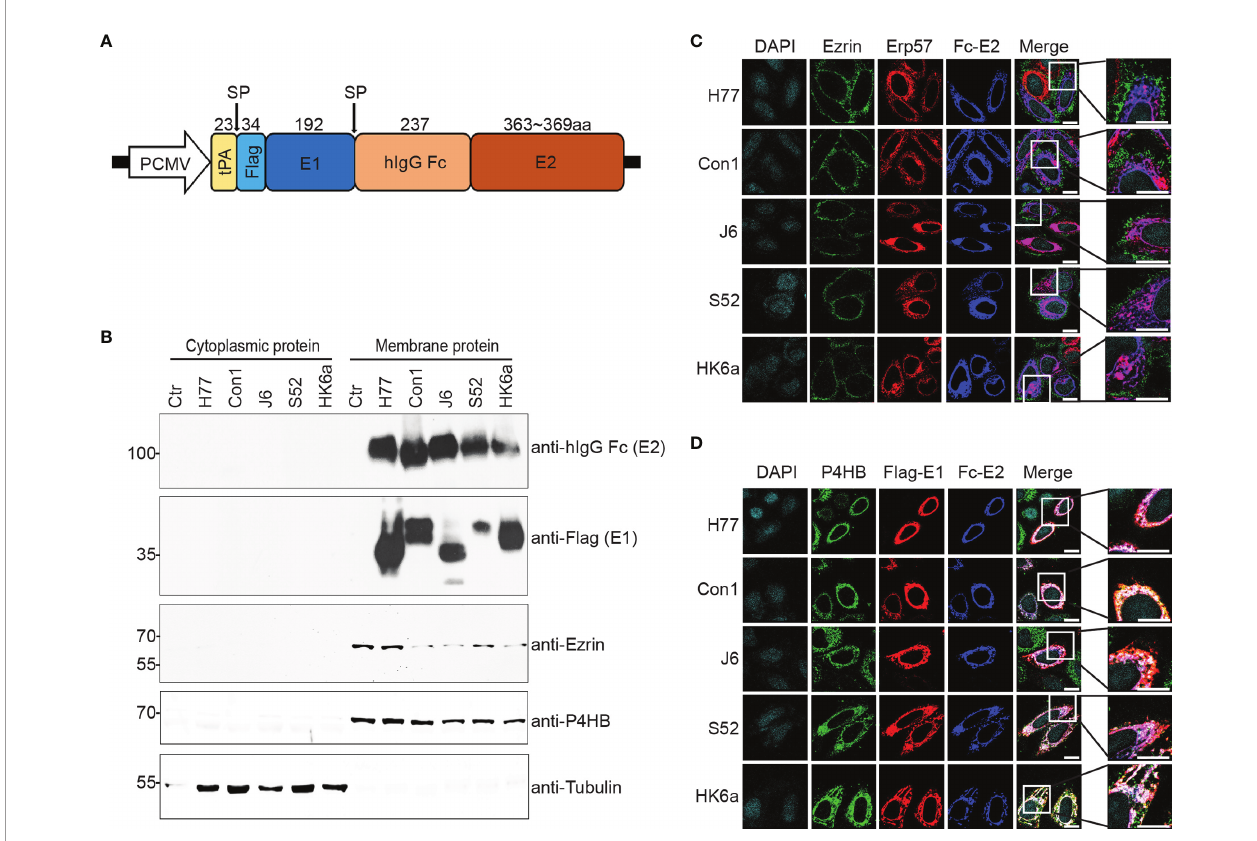
FIGURE 1 | Construction, expression and puri fi cation of Fc-E1E2. (A) Schematic representation of the Fc-E1E2 expression plasmid. The full E1E2 was tagged with the tissue plasminogen activator (tPA) signal sequence and fl ag-tag at the N-terminus of E1, and the human IgG1 Fc fragment (hIgG Fc) was inserted between E1 and E2. The cleavage sites by signal peptidase (SP) and the size of the polypeptide regions (aa, amino acids) are shown at the top. (B) Western blotting (with anti- hIgG Fc, anti-Flag, anti-Ezrin, anti-P4HB, and anti-tubulin antibodies) of cytoplasmic and membrane extracts from FreeStyle 293-F cells. (C, D) The subcellular location of E2 and ER colocalization of E1 and E2 were revealed using confocal laser microscopy. The nuclei were stained with DAPI, and the ER was detected with anti-P4HB and anti-HA (Erp57 expression plasmid was tagged with HA) antibodies. The plasma membrane was detected with anti-Ezrin antibodies. Scar bar = 10 m m. P4HB, Prolyl 4-hydroxylase subunit beta. Erp57, Protein disul fi de isomerase family A member 3. ER, Endoplasmic reticulum. Data are shown as a representative result from at least three independent